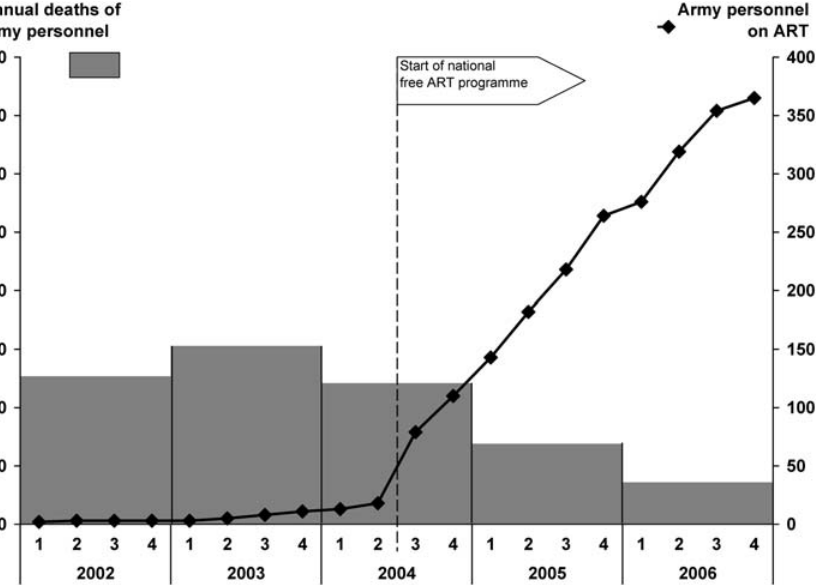
Figure 1. Number of army personnel alive and on antiretroviral therapy and the annual number of deaths of army personnel: 2002–2006. doi:10.1371/journal.pone.0001445.g001 PLoS ONE |